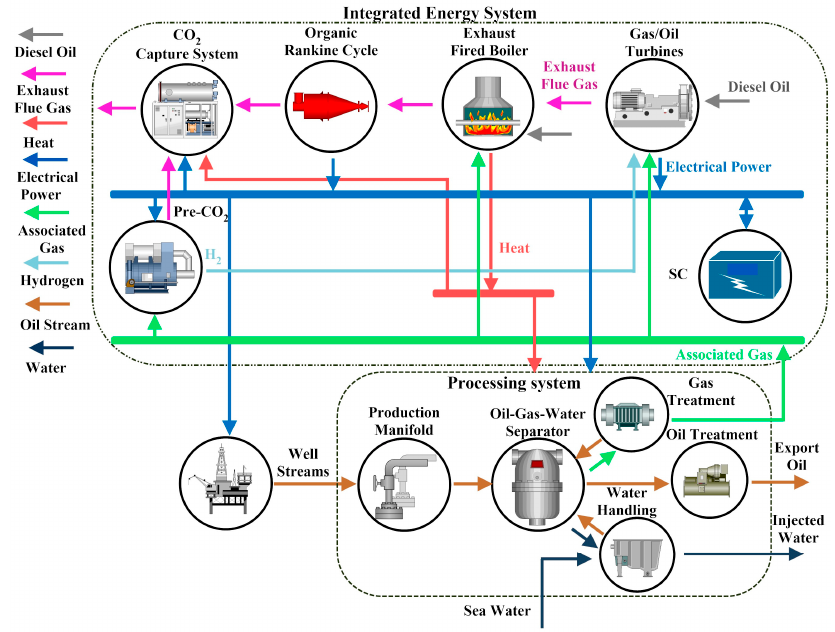
Figure 1. The structure of the proposed IESs for offshore oil platforms.